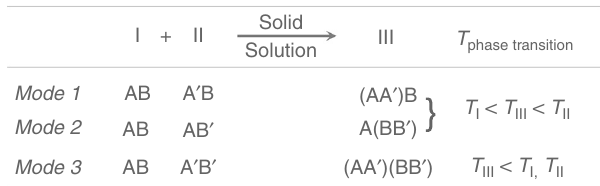
Fig. 2 Molecular-level mixing of two phase-changeable 1D CPs using a dual mixing strategy. Unequal anionic chains are represented by zigzag chains with different bending degree, and distinct guest ammonium templates are represented by ellipsoids with different